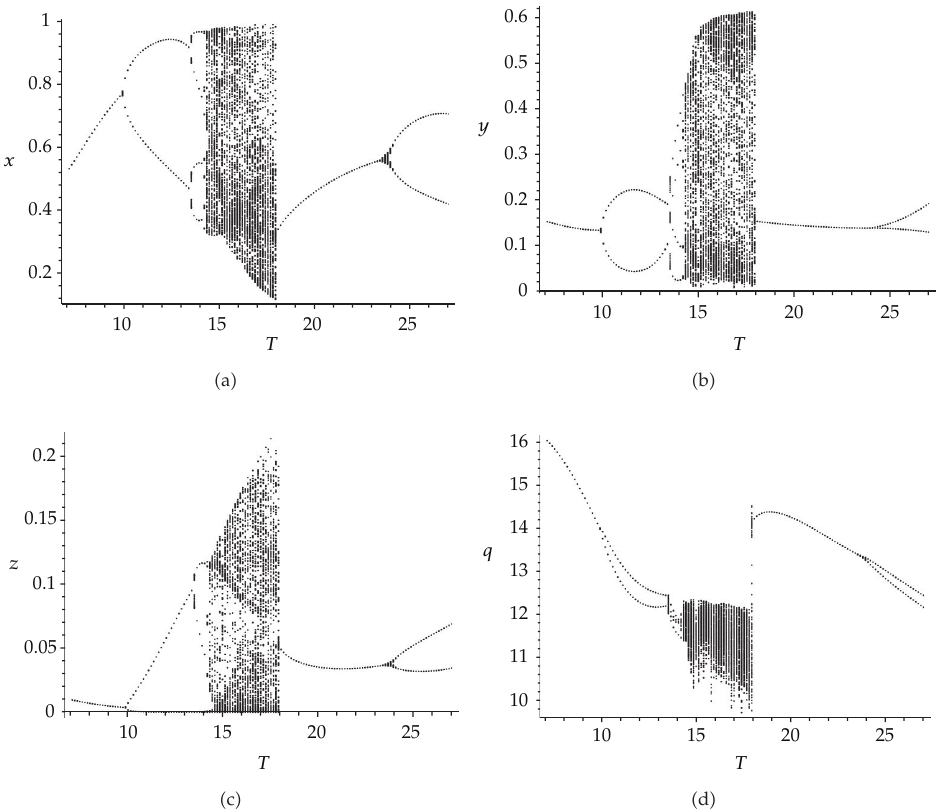
Figure 3: Bifurcation diagram of system (cid:2) 1.3 (cid:3) with initial conditions x (cid:2) 0 (cid:3) (cid:7) 0 . 1 ,y (cid:2) 0 (cid:3) (cid:7) 0 . 2 ,z (cid:2) 0 (cid:3) (cid:7) 0 . 3 ,q (cid:2) 0 (cid:3) (cid:7) 0 . 4, 7 ≤ T ≤ 27, b (cid:7) 10, d (cid:7) 3, c (cid:7) 3, e (cid:7) 0 . 5, f (cid:7) 5, g (cid:7) 2 . 5, h (cid:7) 0 . 1, m (cid:7) 2; j (cid:7) 0 . 2, k (cid:7) 0 . 3, l (cid:7) 0 . 01, a (cid:7) 1 . 3, and p (cid:7) 0 .